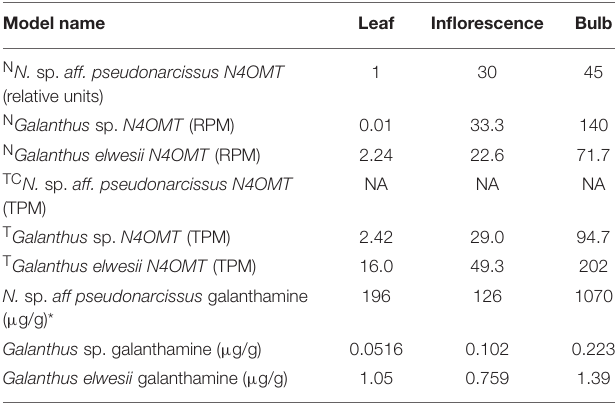
TABLE 1 | Models used in HAYSTACK